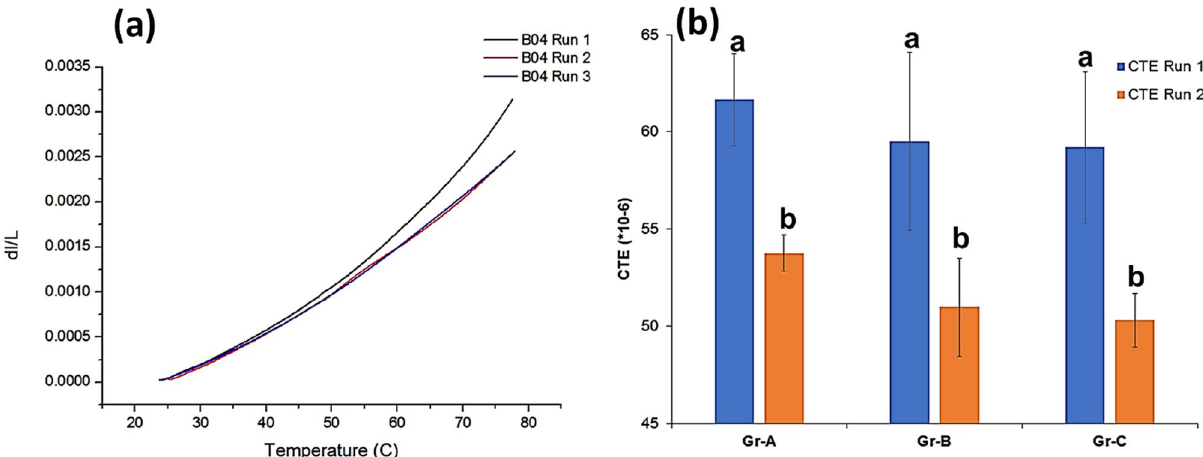
Figure 5. ( a ) variation of thermal strain between 25 and 80 °C intervals of sample B04 (run 1) and subsequent two runs (runs 2 and 3) ( b ) Mean and standard deviation of CTE for three groups between 25 and 80 °C at 5 °C intervals from run 2. Groups with the same alphabets are not significantly different from each other (p >